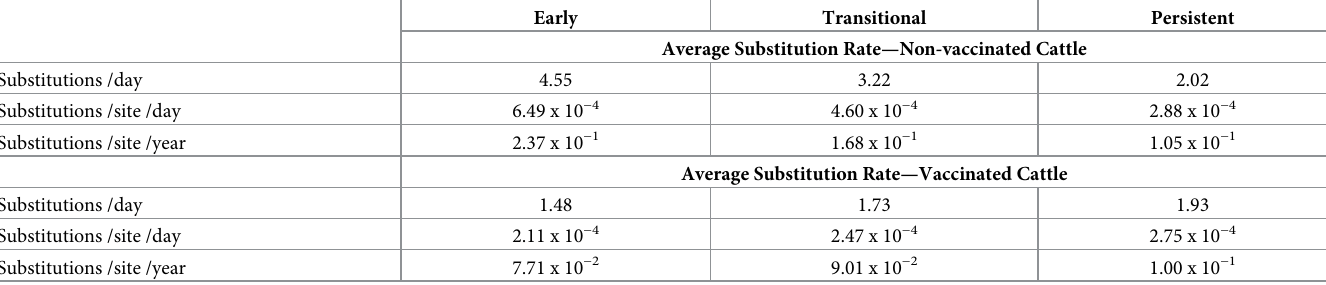
Table 2. Nucleotide substitution rates averaged across non-vaccinated and vaccinated